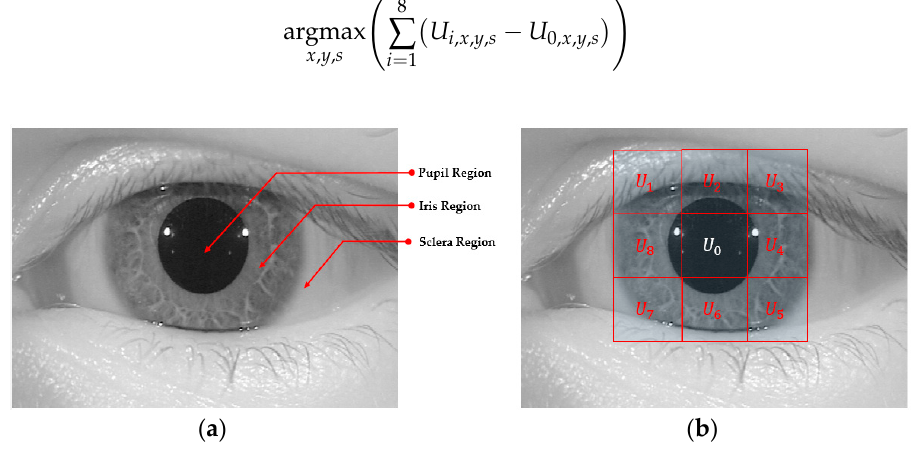
Figure 3. Block-based method for pupil region detection. ( a ) Pupil, iris, and sclera regions of eye image. ( b ) Example of 9 sub-blocks on pupil and iris regions.